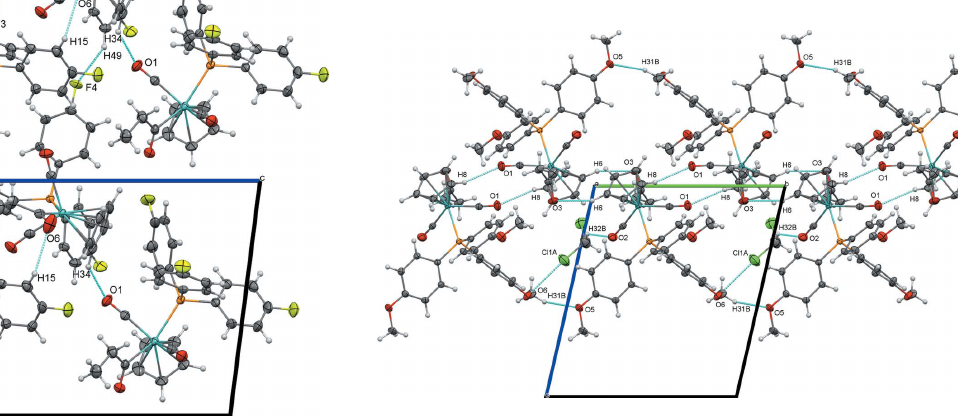
Figure 9 Network of complex ( 3 ) formed by interactions featuring methoxy groups and dichloromethane solvent, viewed along [100].